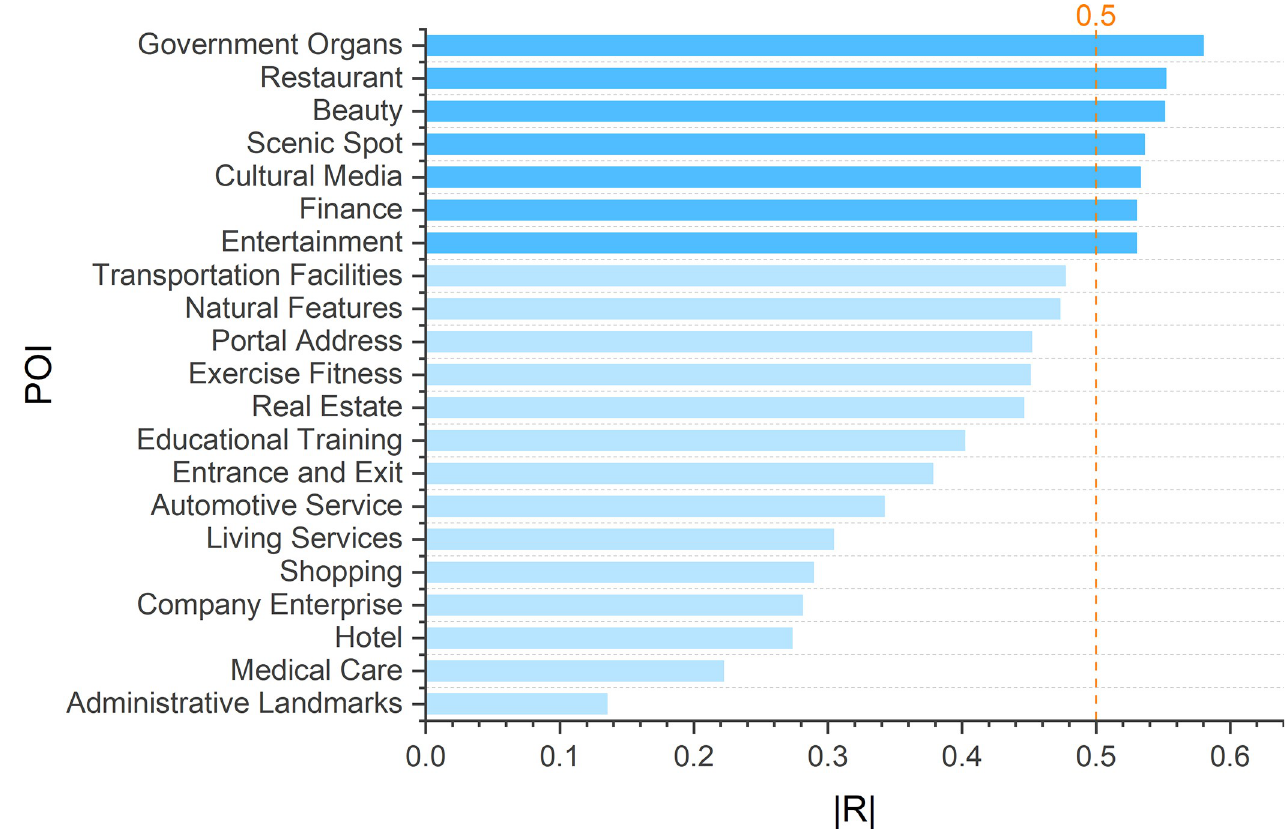
Fig 5. Absolute value of spearman correlation coefficient between the mean kernel density and RPI str of township streets of 21 POIs. Correlation is significant at the 0.01 level (2-tailed).